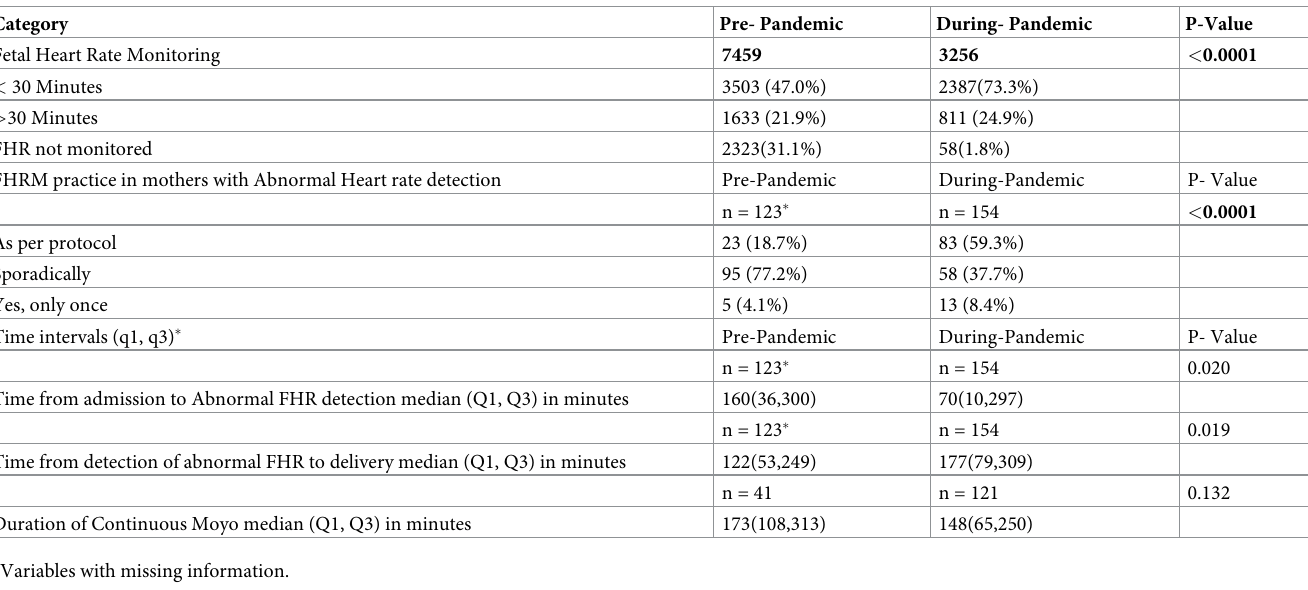
Table 4. Frequency of intrapartum FHR monitoring pre and during pandemic